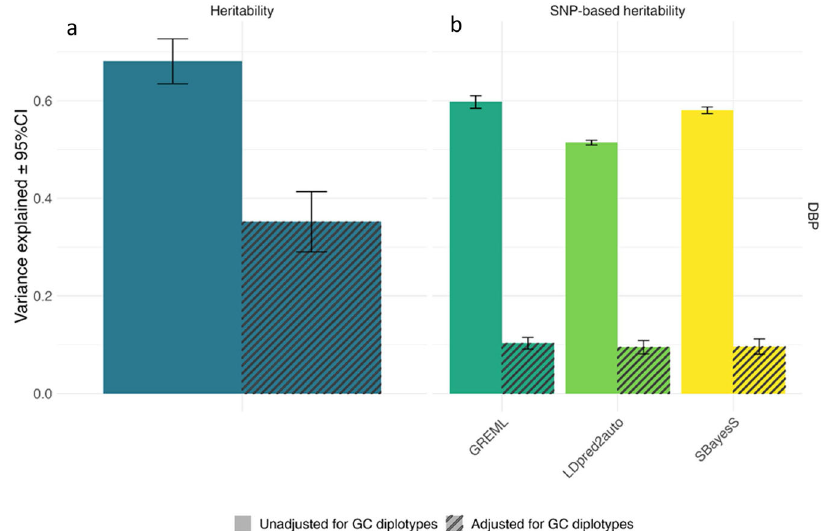
Fig. 3 | Heritability and SNP-based heritability of DBP. Heritability ( a ) and SNP- based heritability ( b ) estimates for DBP, with and without adjustment for GC haplotypes (adjusted values shown with cross-hatching). The family-based herit- ability and GREML estimates are based on the European ancestry subset of